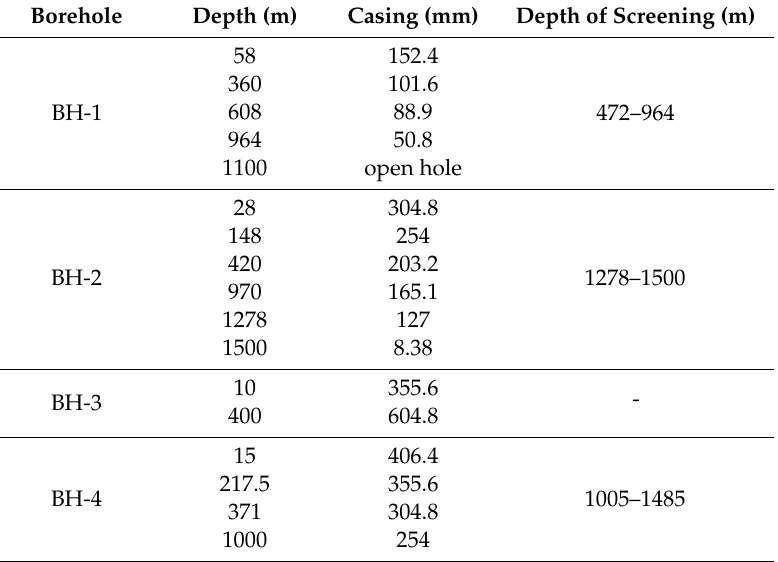
Table A3. Installation of casing and screens at the